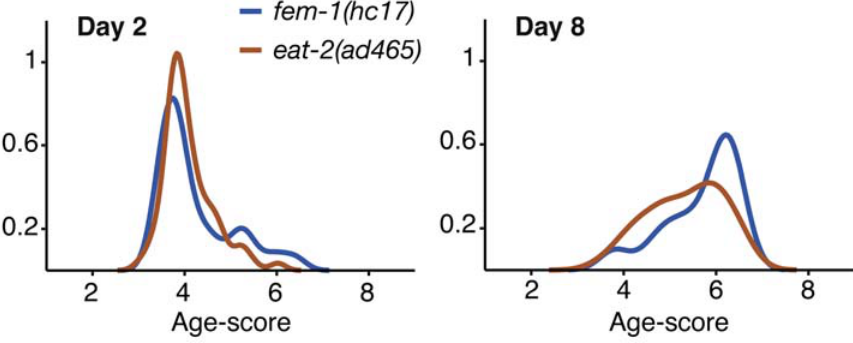
Figure 4. Probability density functions comparing morphological differences between normal and eat-2(ad465) slow-pumping animals at days 2 and 8. The model was trained on normal ( fem-1(hc17) ) animals at days 2 and 8. At day 2, eat-2 mutants were indistinguishable from normal animals, while slightly lower age scores were evident on day 8. doi:10.1371/journal.pone.0002821.g004 PLoS ONE |